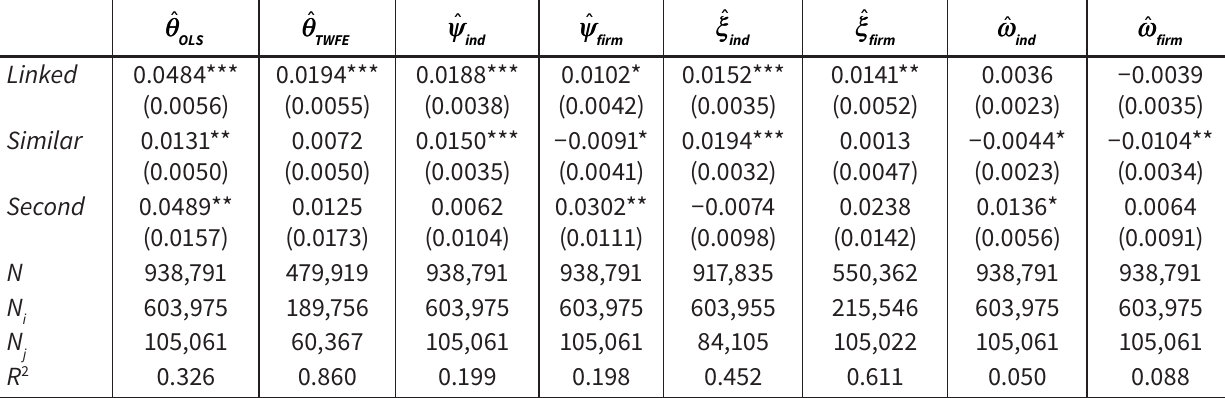
Table 8 Gains from links, second links, and similar workers